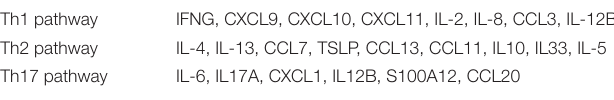
TABLE 2 | Proteins profiled in COVID-19 serum by